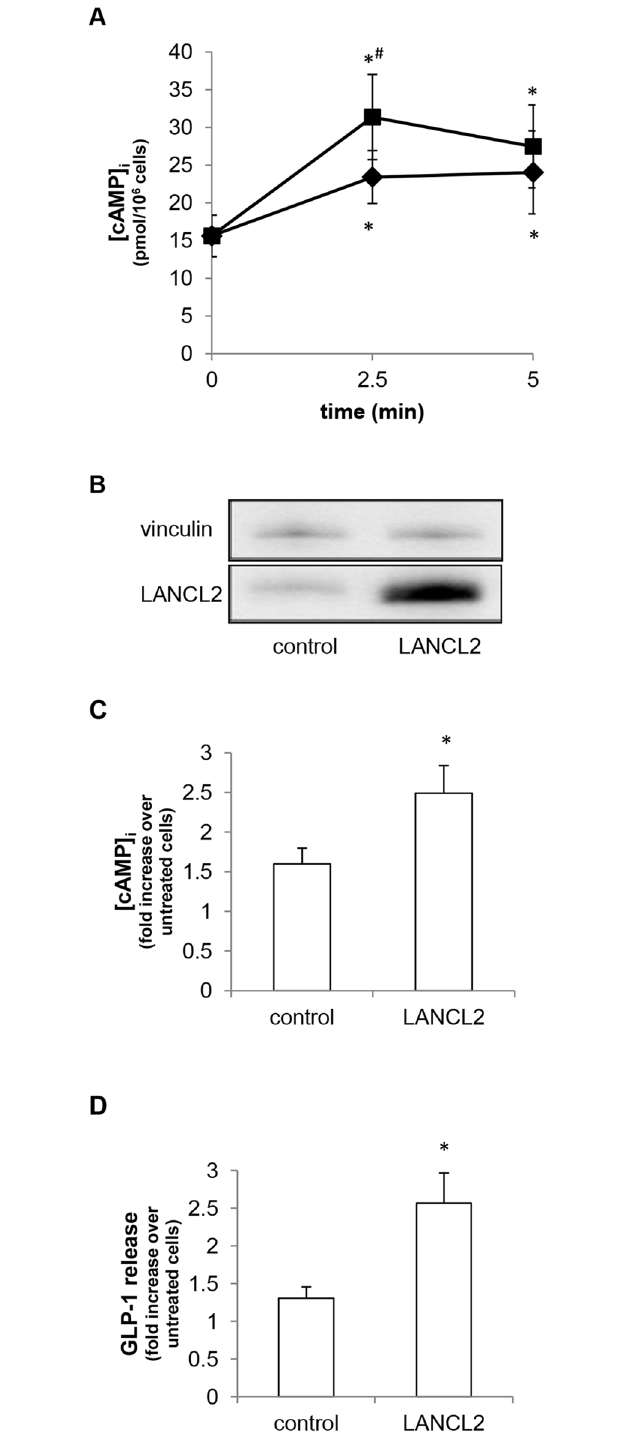
Fig 2. ABA induces the increase of the [cAMP] i in hNCI-H716 cells. (A) hNCI-H716 cells were incubated for the indicated time in the absence or presence of 200 μ M ABA (squares), or of 10 mM glutamine (rhombi); [cAMP] i was then measured on cell extracts. Data are mean ± SD of at least 3 different experiments; * , p < 0.05 compared with untreated cells; #, p < 0.05 compared to glutamine-treated cells (for the same time). (B) hNCI-H716 cells were transfected with an empty plasmid (control) or with a LANCL2-containing plasmid (LANCL2). After 48 h from transfection, cells were lysed and a Western blot analysis was performed using